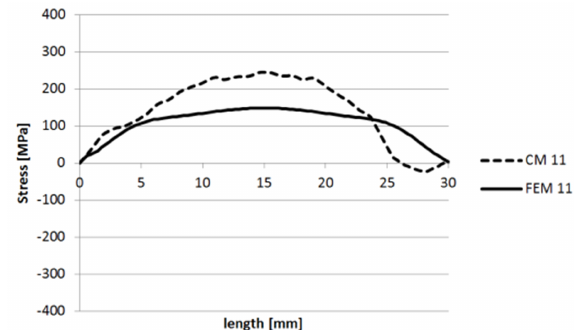
Figure 47. Stress levels in 11 direction along the CD line segment.